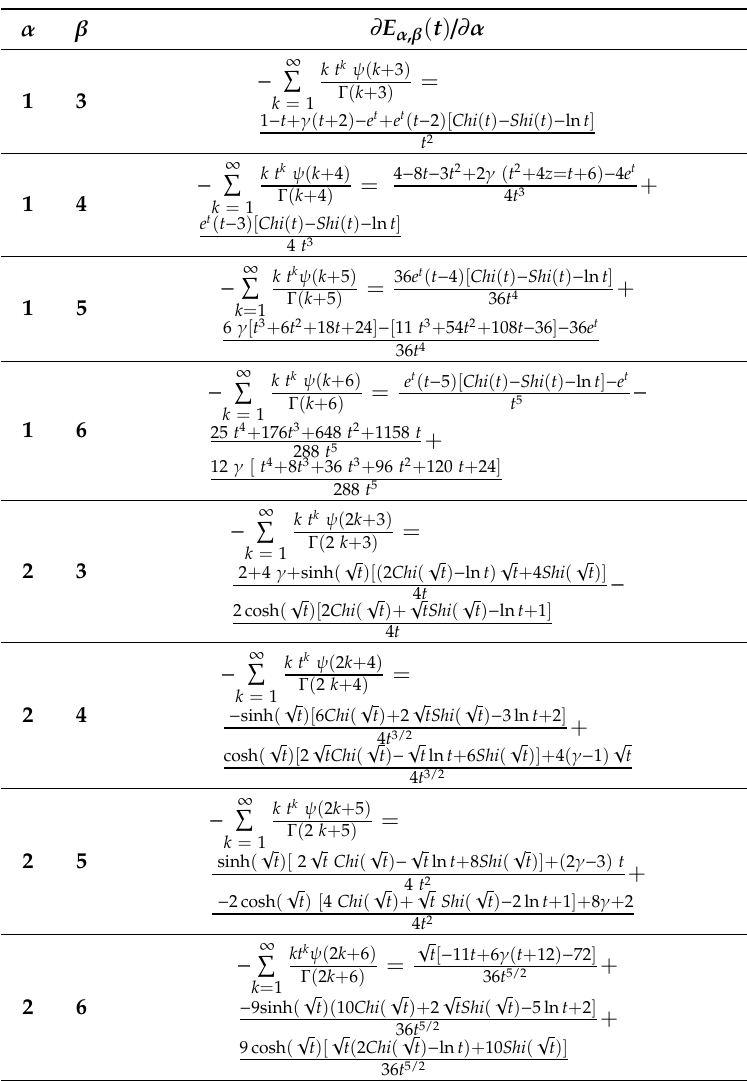
Table 1. First derivatives of the Mittag-Le ffl er functions with respect to the parameter α . α β ∂ E α